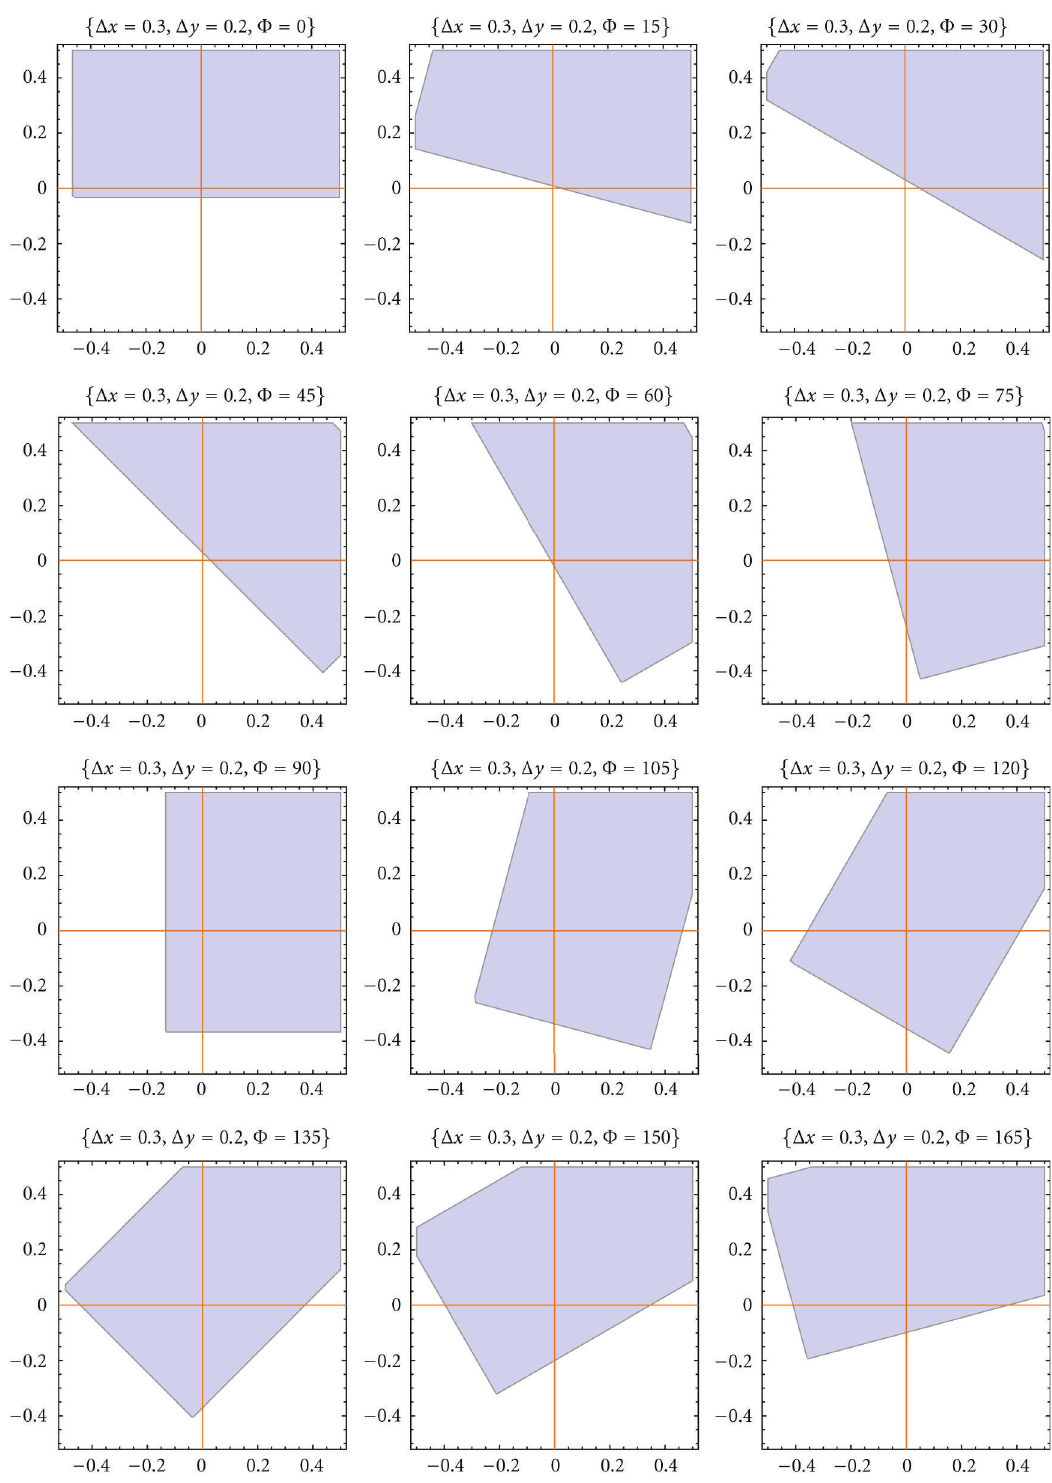
Figure 7: Demonstration for target size of 4/3 over 2/3 with origin at (0.3,0.2) and di ff erent rotation